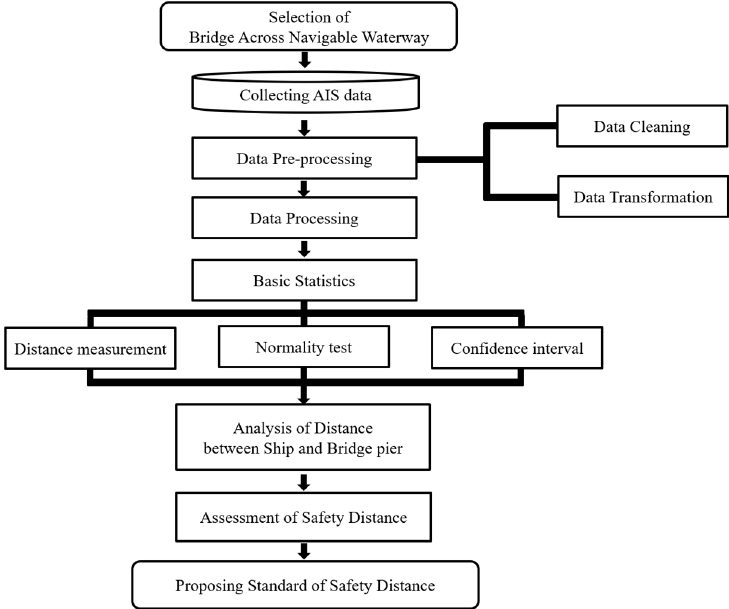
Figure 3. Flow chart used for investigating the safety distance between a ship and the bridge pier.